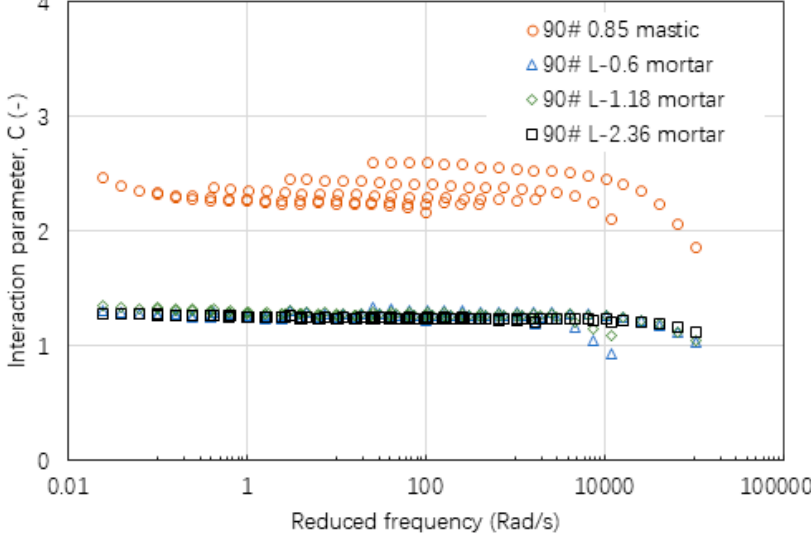
Figure 15. Interaction parameter of C values for asphalt mastic and mortar based on AC ‐ 25 mixture.